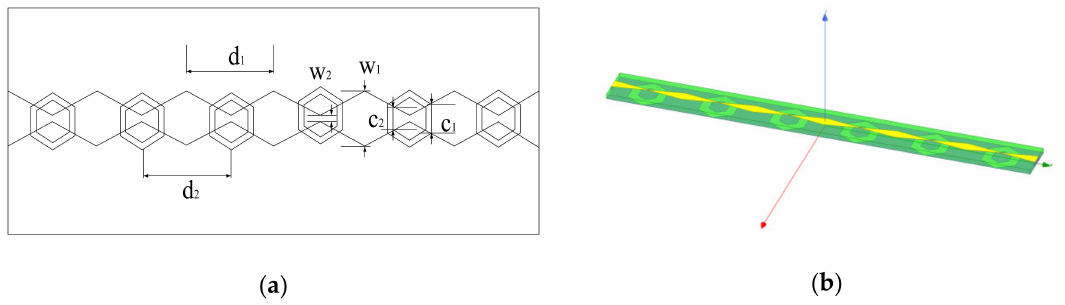
Figure 4. ( a ) Perspective view of microstrip band stop filter etching of a periodic hexagon ring electromagnetic band gap structure (EBGs); ( b ) 3D picture of a microstrip band stop filter etching of a periodic hexagon ring EBGs.